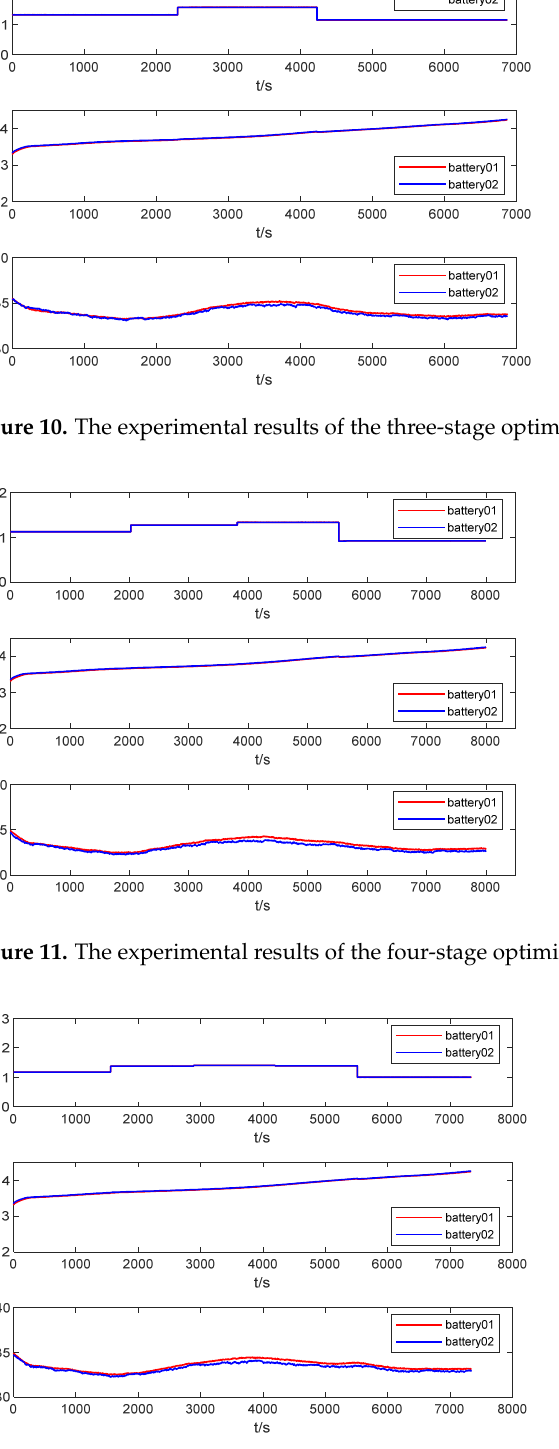
Figure 12. The experimental results of the five-stage optimized constant current charging strategy.